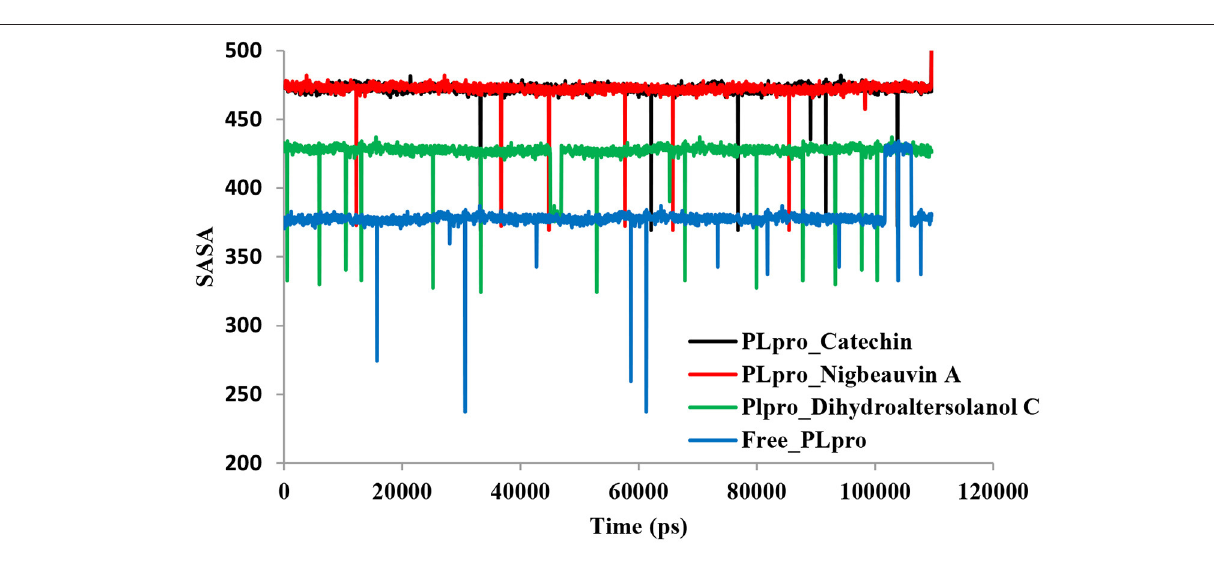
Frontiers in Medicine |